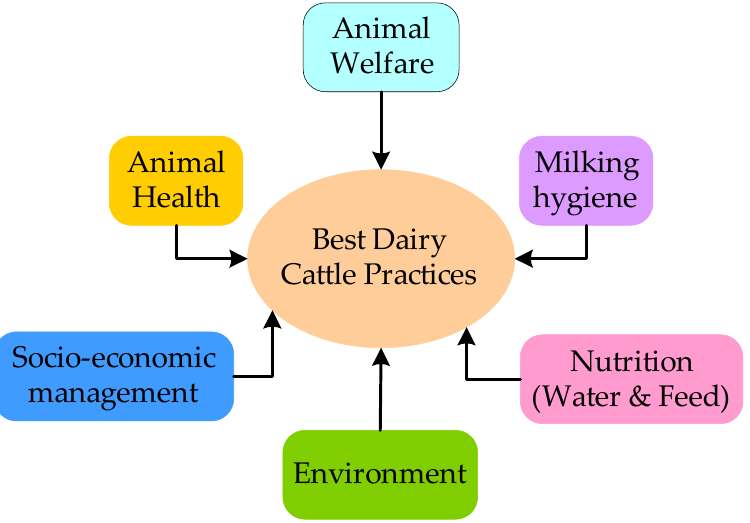
Figure 2. Best Dairy Cattle Practices.